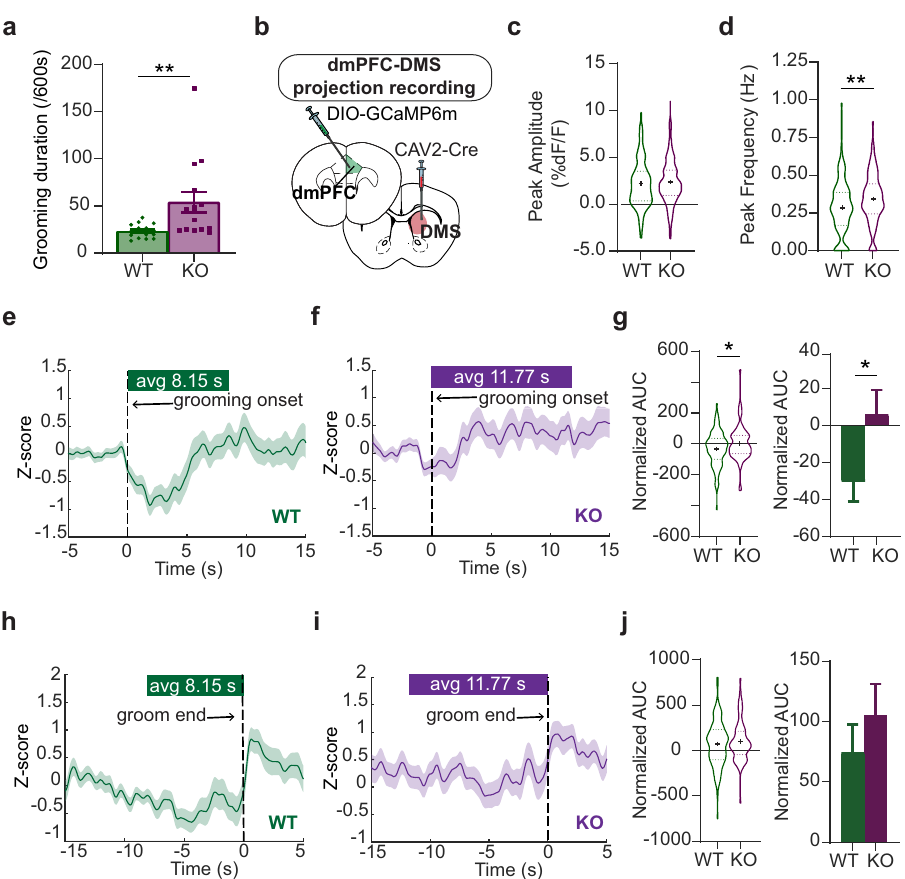
Fig. 1 Grooming-associated changes in fronto-striatal activity. a KO mice groom more than WT littermates (unpaired two-tailed t -test P = 0.0083; WT = 15, KO = 15). b Mice are injected with CAV2-Cre in the DMS and Cre-dependent GCaMP6m in the dmPFC, with optical fi bers implanted in the dmPFC. c Peak amplitude of calcium transients (unpaired two-tailed t test, P = 0.2709, WT = 130 grooming epochs from 11 mice, KO = 118 grooming epochs from 10 mince). d Frequency of calcium transients during grooming (unpaired two-tailed t -test P = 0.0090; WT = 130 grooming epochs from 11 animals, KO = 118 grooming epochs from 10 animals). e PETH of averaged z-score calcium signals aligned to the start of grooming in WT mice (green line, N = 113 groom epochs from 11 WTs, green bar above represents average length of WT grooming epochs). f KO PETH of averaged z-score calcium signals during grooming (purple line, purple bar above represents average length of grooming epochs for KO, N = 73 groom epochs from 10 KOs). g Normalized area under the curve (AUC) analysis of calcium signal during grooming shown as truncated violin plot (left) and bar graph (right) (unpaired two-tailed t - test P = 0.0342; WT = 113 groom epochs from 11 animals, KO = 73 groom epochs from 10 animals). h PETH of averaged z-score signals aligned to the end of grooming in WT mice ( N = 113 groom epochs from 11 WTs). i KO PETH of averaged z-score signals aligned to the end of grooming ( N = 73 groom epochs from 10 KOs). j AUC analysis of calcium signal post-grooming shown as truncated violin plot (left) and bar graph (right) (unpaired two-tailed t -test P = 0.3961, WT = 113 groom epochs from 11 WTs, KO = 73 groom epochs from 10 KOs). Bar graphs and peri-event time histograms (PETH) show data means + / − SEM. Truncated violin plots end at distribution minimum and maximum, dotted lines mark 25% and 75% quartiles, cross denotes mean. Source data are provided as a Source data fi le. * P < 0.05, ** P <